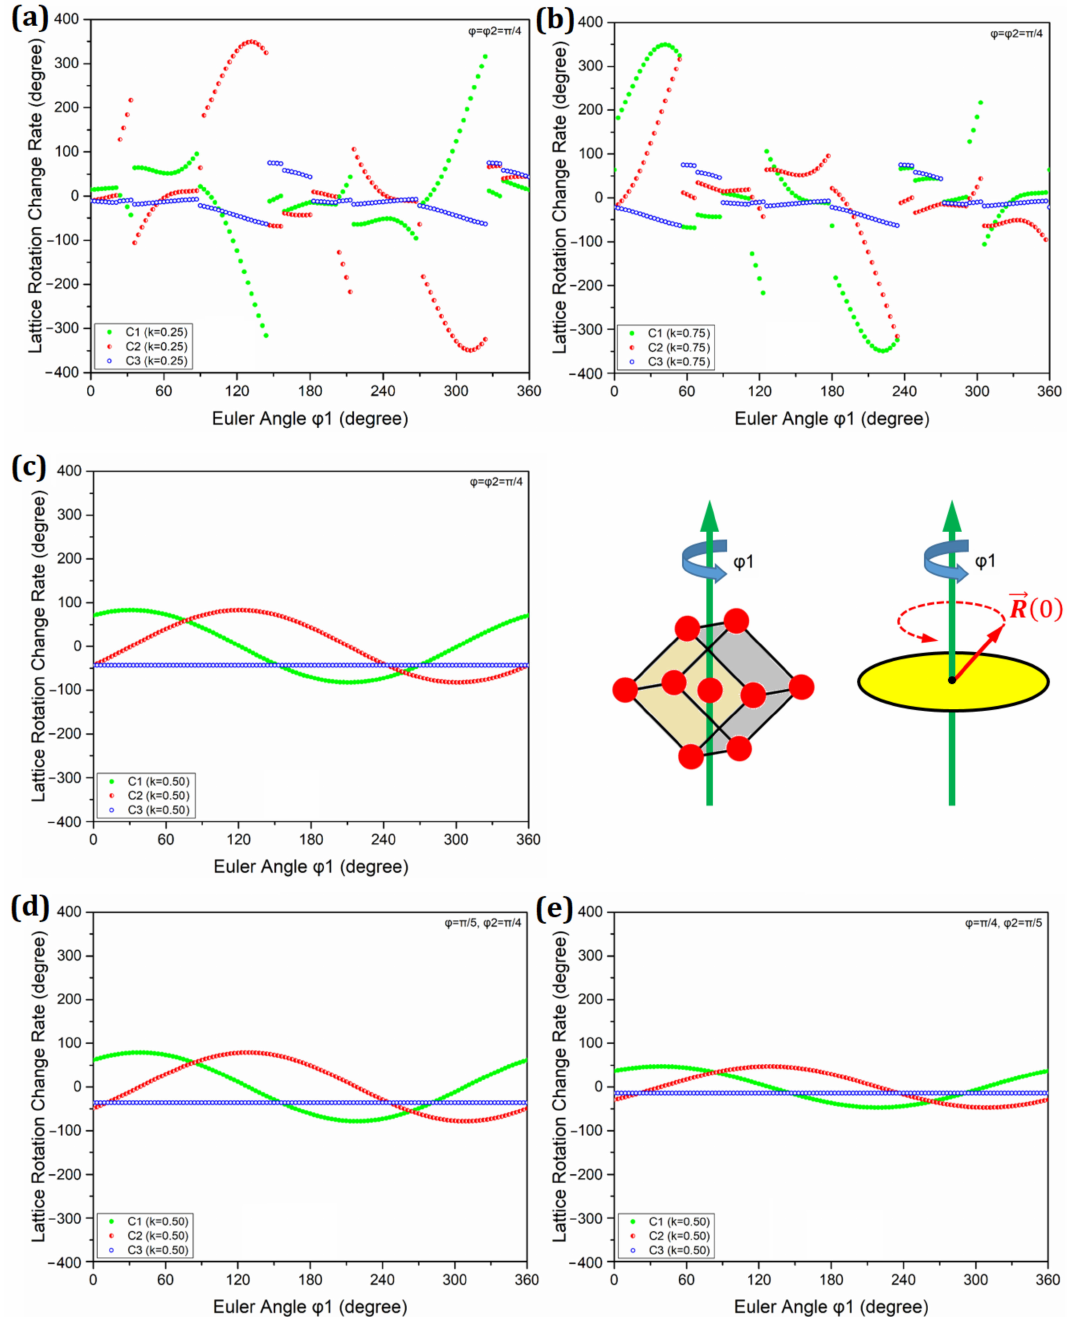
Figure 11. Influence of variable k and Euler angles φ 1 , φ , φ 2 on lattice rotation change rates C 1 ∼ 3 in cases of: ( a ) k = 0.25, φ = φ 2 = π /4; ( b ) k = 0.75, φ = φ 2 = π /4; ( c ) k = 0.50, φ = φ 2 = π /4; ( d ) k = 0.50, φ = π /5, φ 2 = π /4; ( e ) k = 0.50, φ = π /4, φ 2 = π /5 ( φ 1 ranges from 0 ◦ to 360 ◦